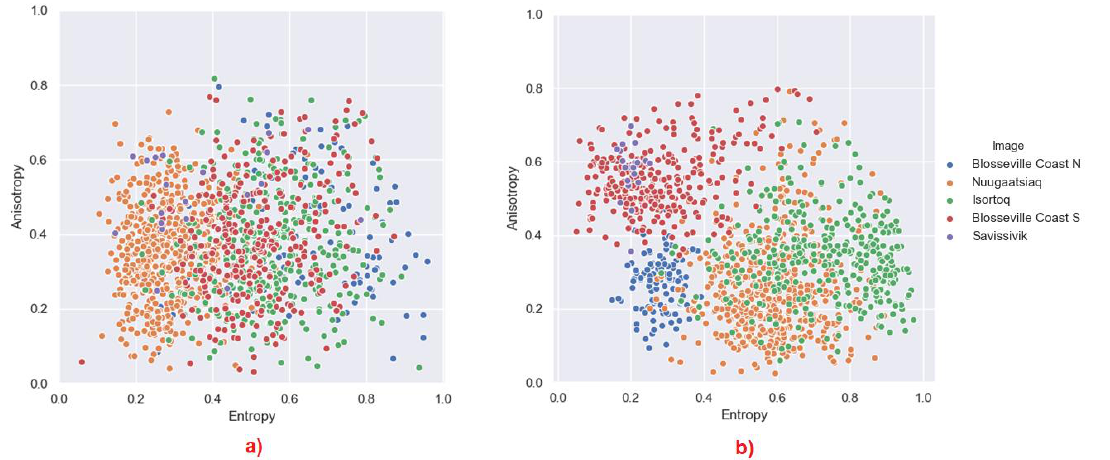
Figure 16. ( a ) . Iceberg anisotropy boxplot 5 × 5 window ( b ) 11 × 11 window. Slight changes in beta are evident in Blosseville Coast N, and Savissivik.